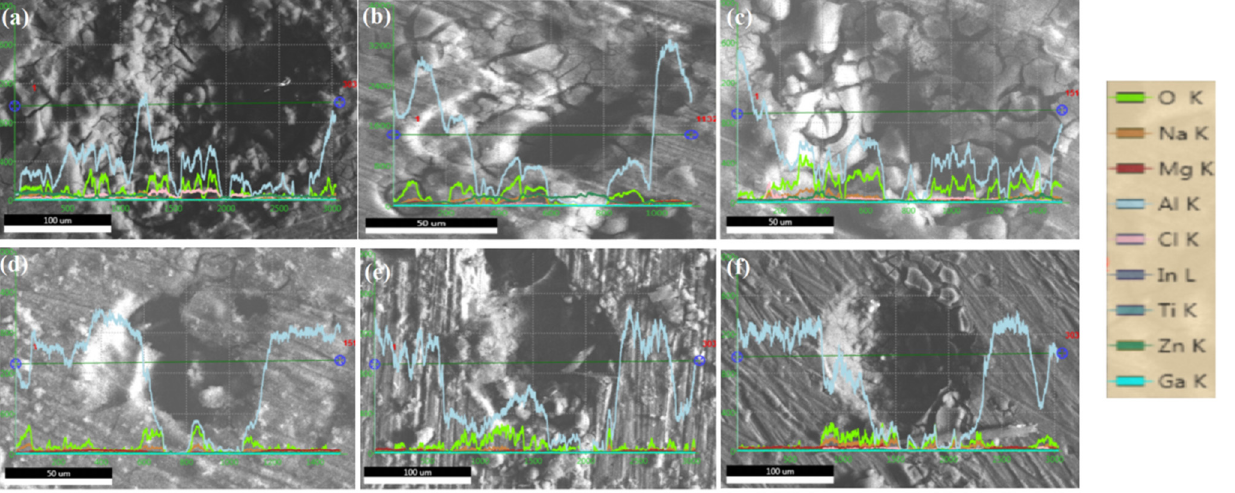
Figure 7. SEM images of surface morphologies and the corresponding elemental distributions for the six investigated anodes with different Ga percentages: ( a ) 0, ( b ) 0.01wt%., ( c ) 0.02wt%., ( d ) 0.03wt%., ( e ) 0.04wt%. and ( f ) 0.05wt%.